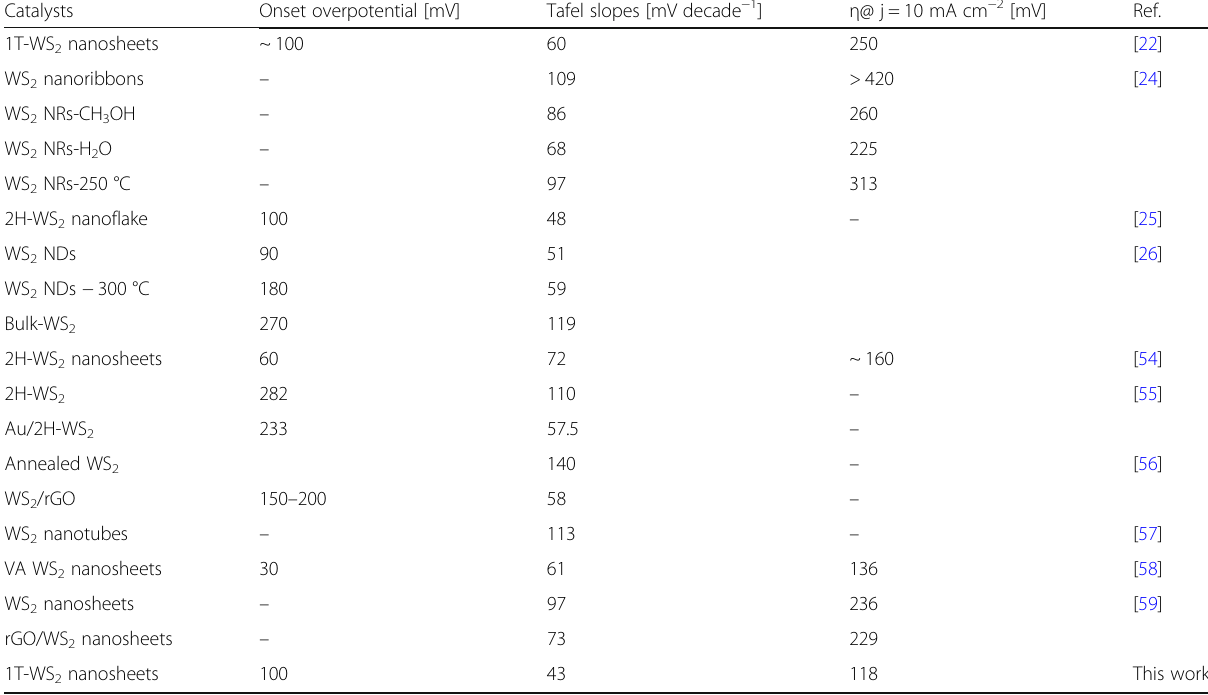
Table 1 Summary of literature catalytic parameters of various WS 2 or WS 2 -based catalysts, recently